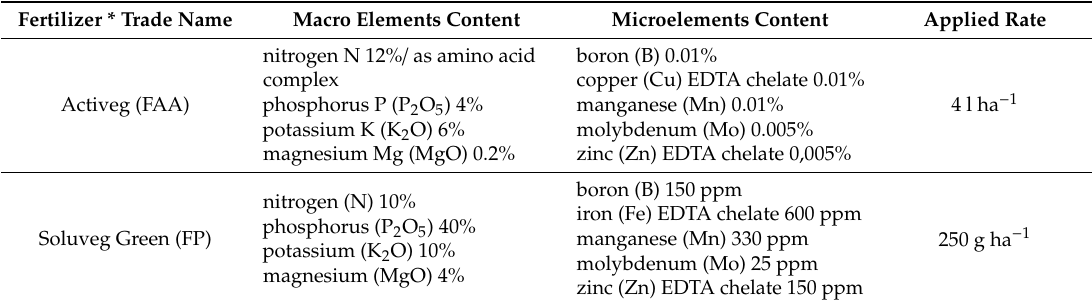
Table 3. Applied fertilizers in the experiment (Activeg (12-4-6 + 0.2MgO + ME + amino acids) and Soluveg Green (10-40-10 + ME)).